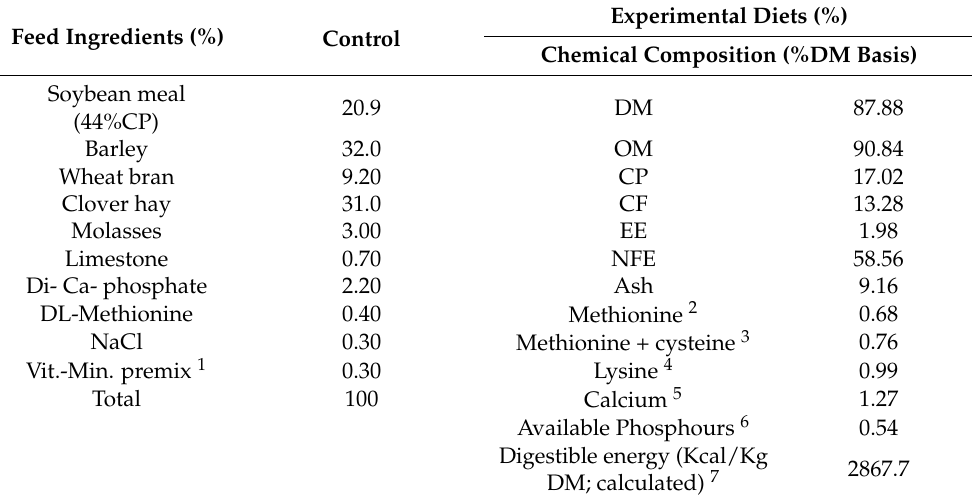
Table 1. Feed ingredients and chemical composition of experimental diets (% DM basis). Feed Ingredients (%)